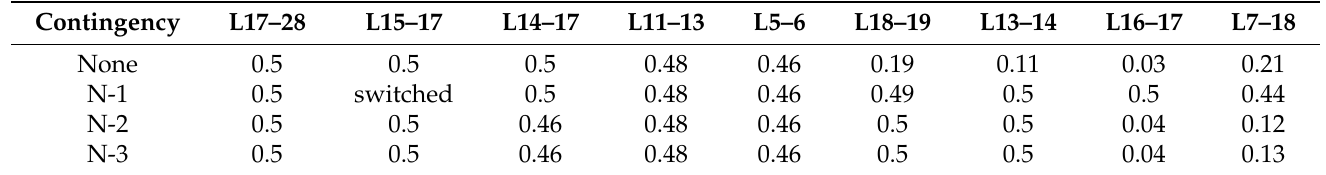
Figure 6. Transmission line loadability. Table 4. Contingency ranking for transmission